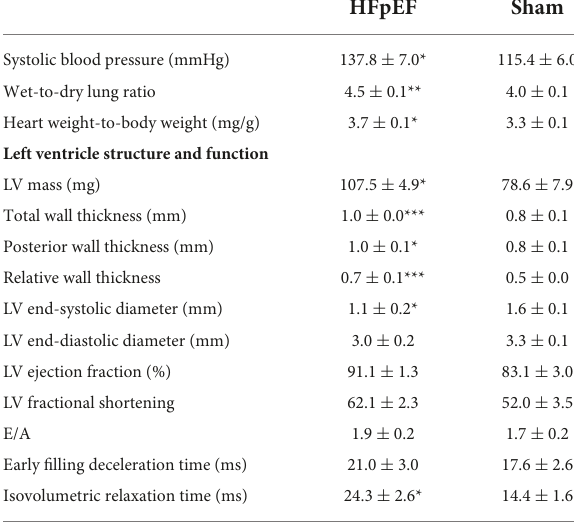
TABLE 1 Characteristics and echocardiographic parameters of HFpEF ( SAUNA ) mice 4 weeks after d -Aldosterone or saline (Sham)